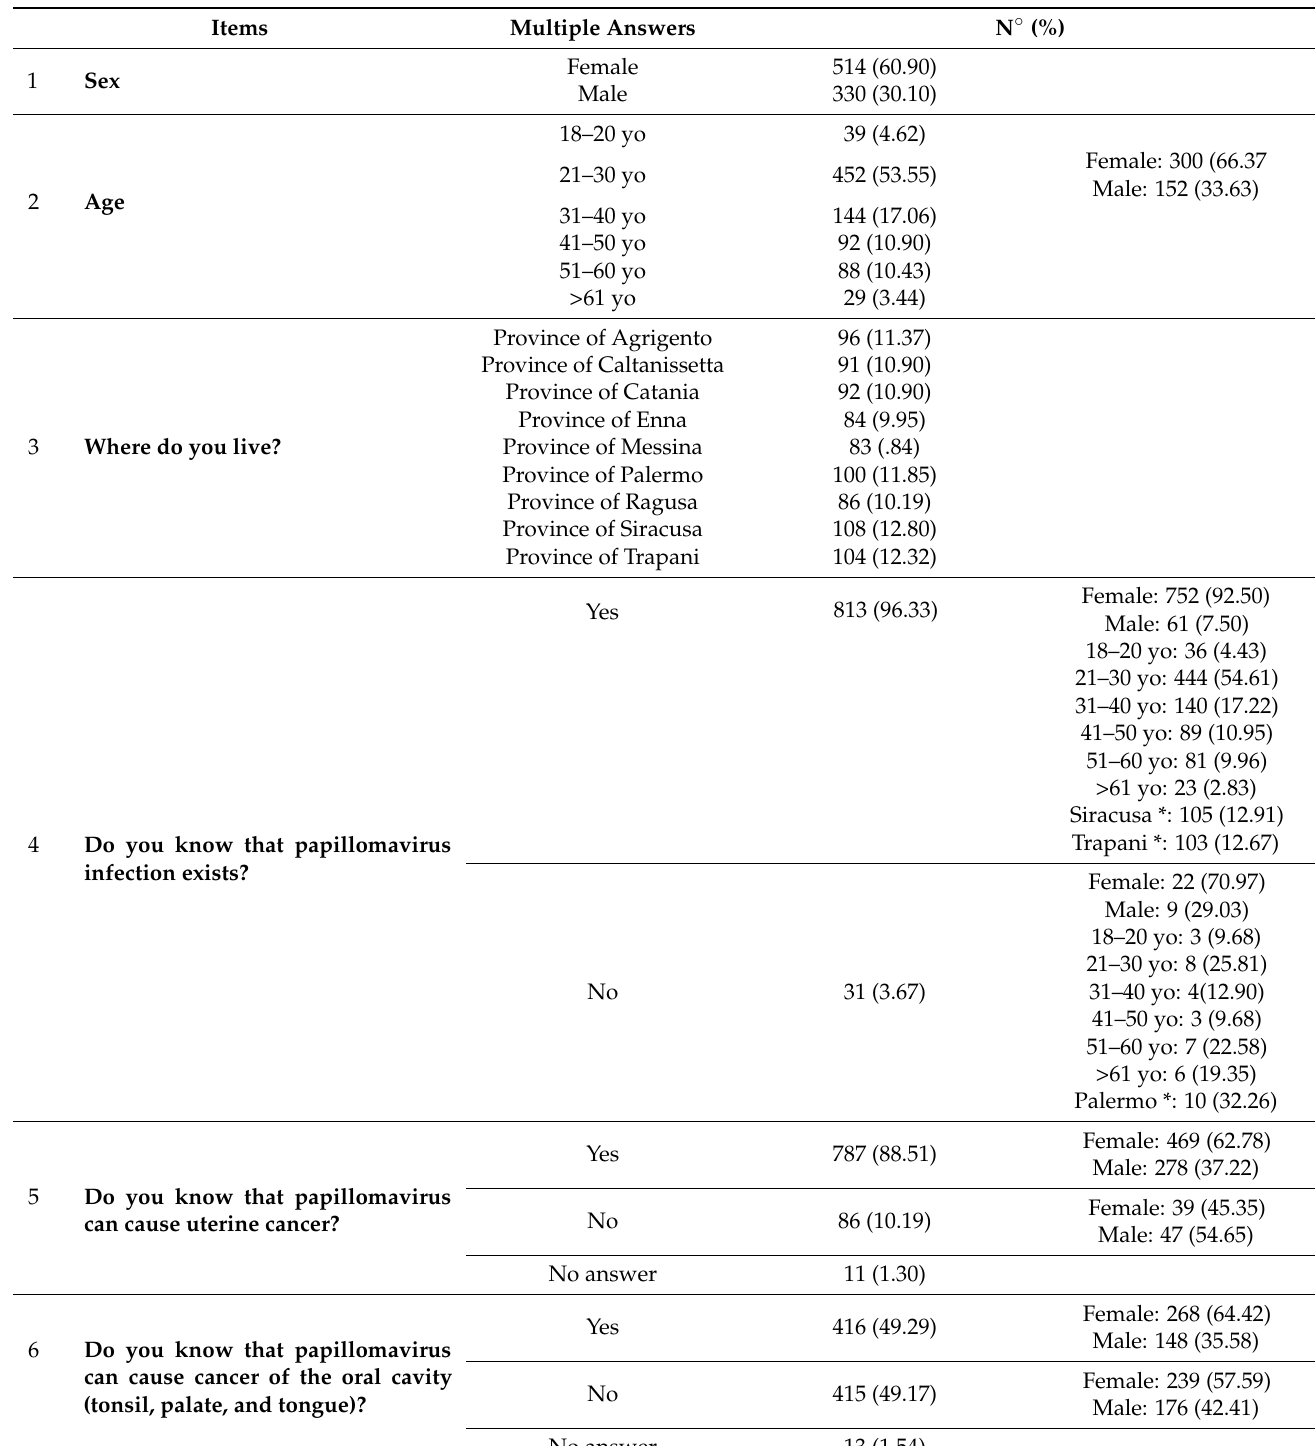
Table 1. HPV survey on Sicilian